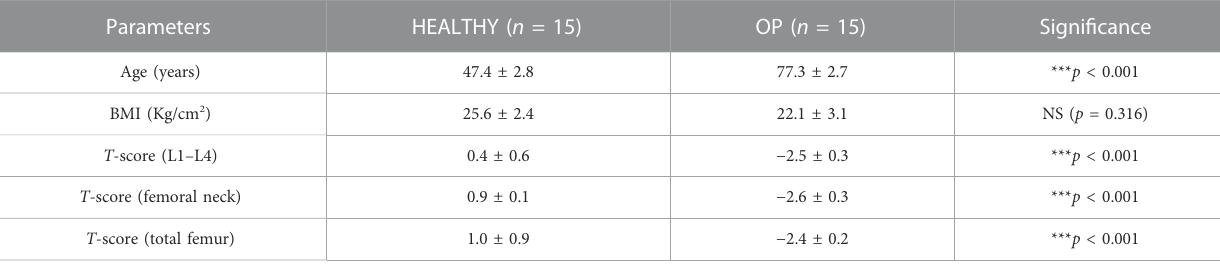
TABLE 1 Clinical characteristics of HEALTHY subjects and OP patients.